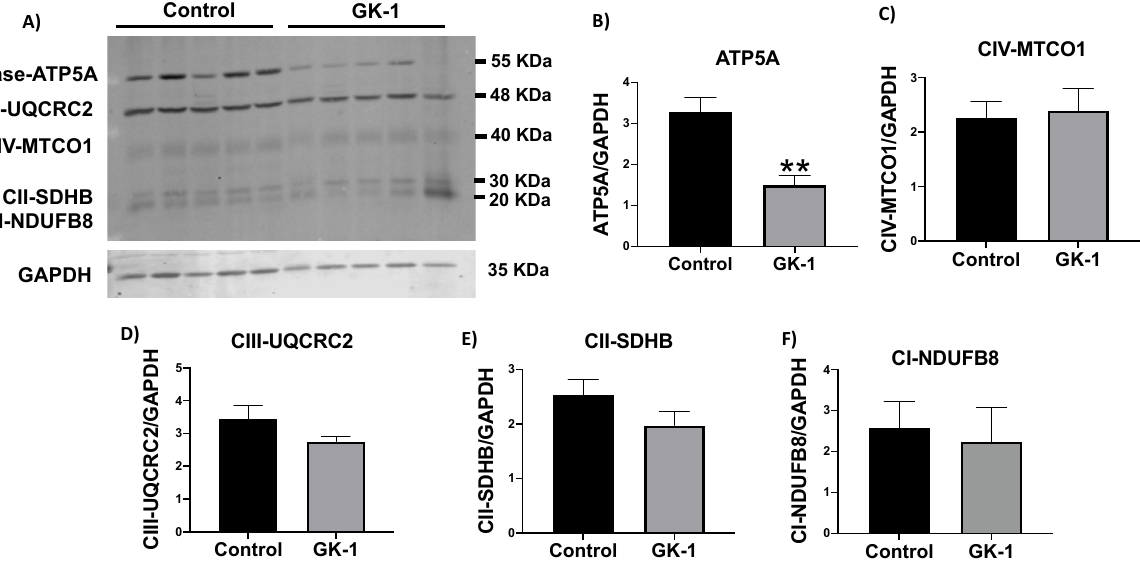
Both results suggest that GK-1 could induce a disruption in the autophagic flux necessary to restore damaged proteins and organelles such as mitochondria.